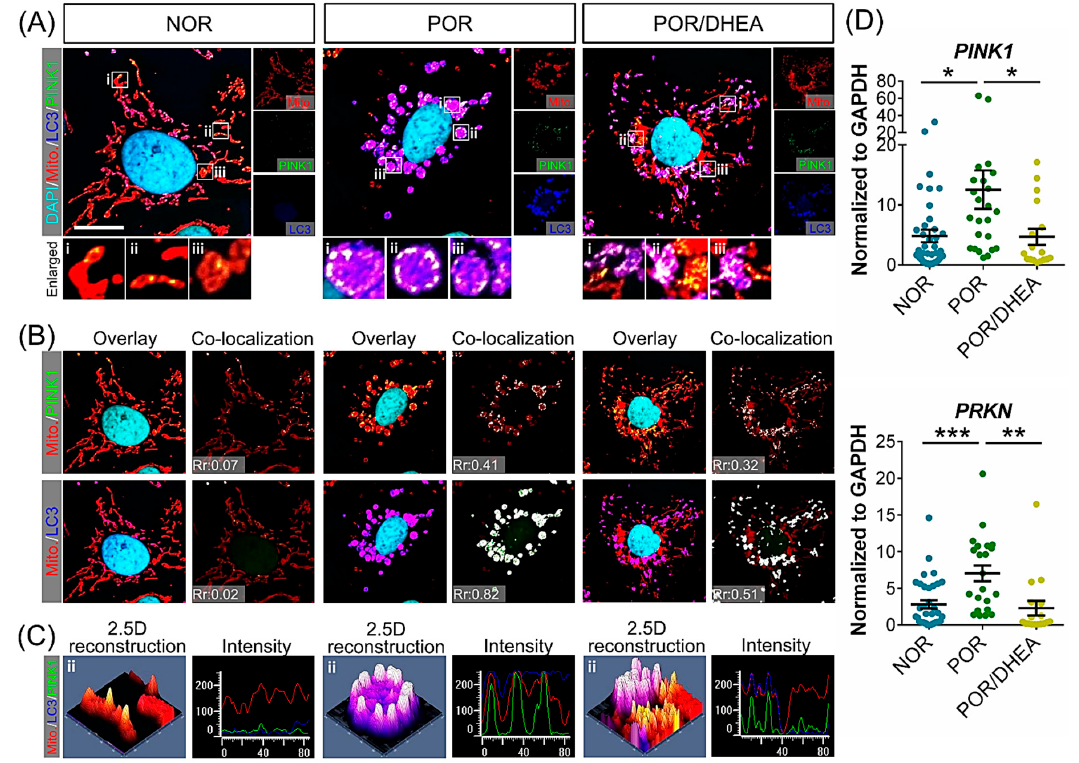
Figure 6. DHEA supplementation decreased mitophagy of cumulus cells (CCs) in poor ovarian responders. ( A ) Confocal images of CCs loaded with MitoTracker, LC3, PINK1, and DAPI. The enlarged images in ( B , C ) highlight the representative co-localization with 30 × magnification from white squares in the overlay images. ( B ) Co-localization analyses of Mito/PINK1 and Mito/LC3. The co-localization in ( B ) is presented as the product of the differences from the mean (PDM) image. White color pixels indicate co-localization coefficient. ( C ) A 2.5-dimensional reconstruction and fluorescence intensity of the respective insets in ( A ) compared between green, red, and blue fluorescence. Data represented the mean ± SEM of 3–5 independent experiments. ( D ) qRT-PCR analysis for relative mRNA levels of mitophagy genes of CCs ( n = 19–28). i-iii: enlarged insets * p < 0.05, ** p < 0.01, *** p < 0.001. Scale bar: 20 μ m.